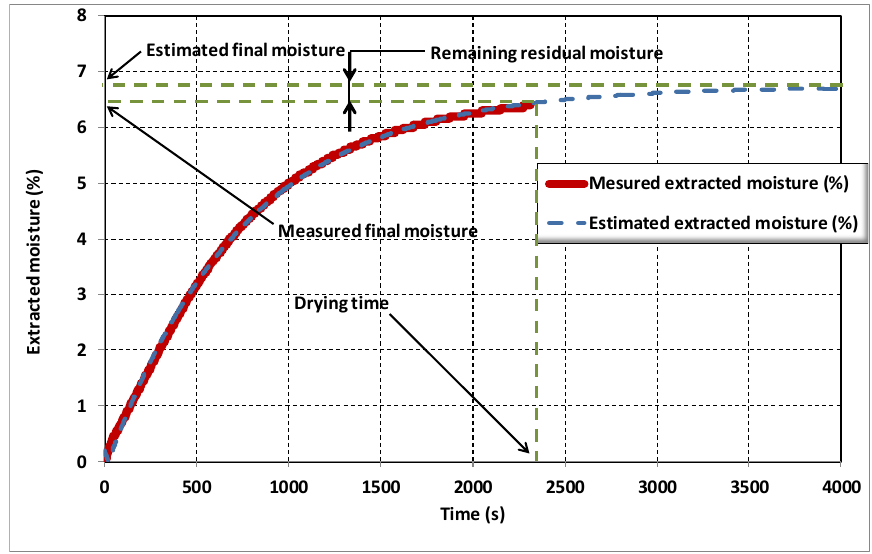
Figure 3. Principle of the estimation of the real and residual moisture.